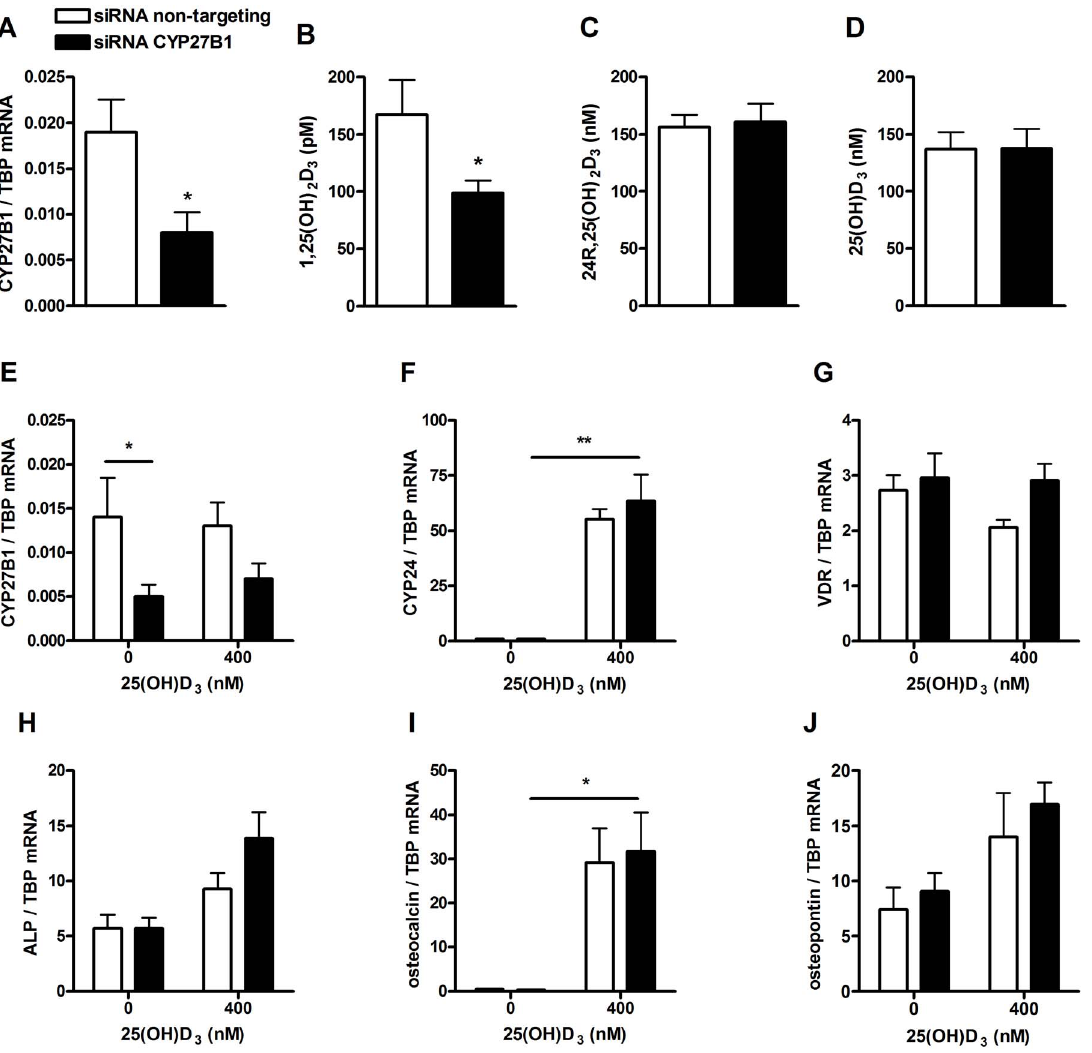
Figure 6. Effects of 25(OH)D 3 on mRNA levels of genes involved in primary human osteoblast differentiation after CYP27B1 silencing. CYP27B1-silenced and control cells were incubated in the presence of 0 or 400 nM 25(OH)D 3 for 3 days. CYP27B1 knock down was determined before 25(OH)D 3 treatment ( A ). After 72 hours incubation with 25(OH)D 3 , we examined levels of 1,25(OH) 2 D 3 ( B ), 24R,25(OH) 2 D 3 ( C ) and 25(OH)D 3 ( D ), and mRNA levels of CYP27B1 ( E ), CYP24 ( F ), VDR ( G ), ALP ( H ), osteocalcin ( I ) and osteopontin ( J ) in CYP27B1-silenced and control cells. Results are expressed as mean 6 SEM using cells from 5 different donors. Results were analysed using Friedman test followed by Dunn’s post hoc test (*p , 0.05, **p , 0.01, ***p , 0.001).